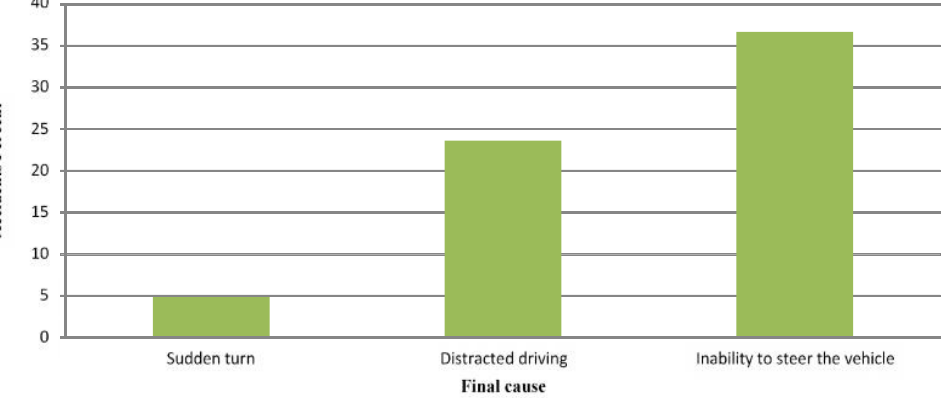
Fig. 6: The definite cause of accidents in the scenarios